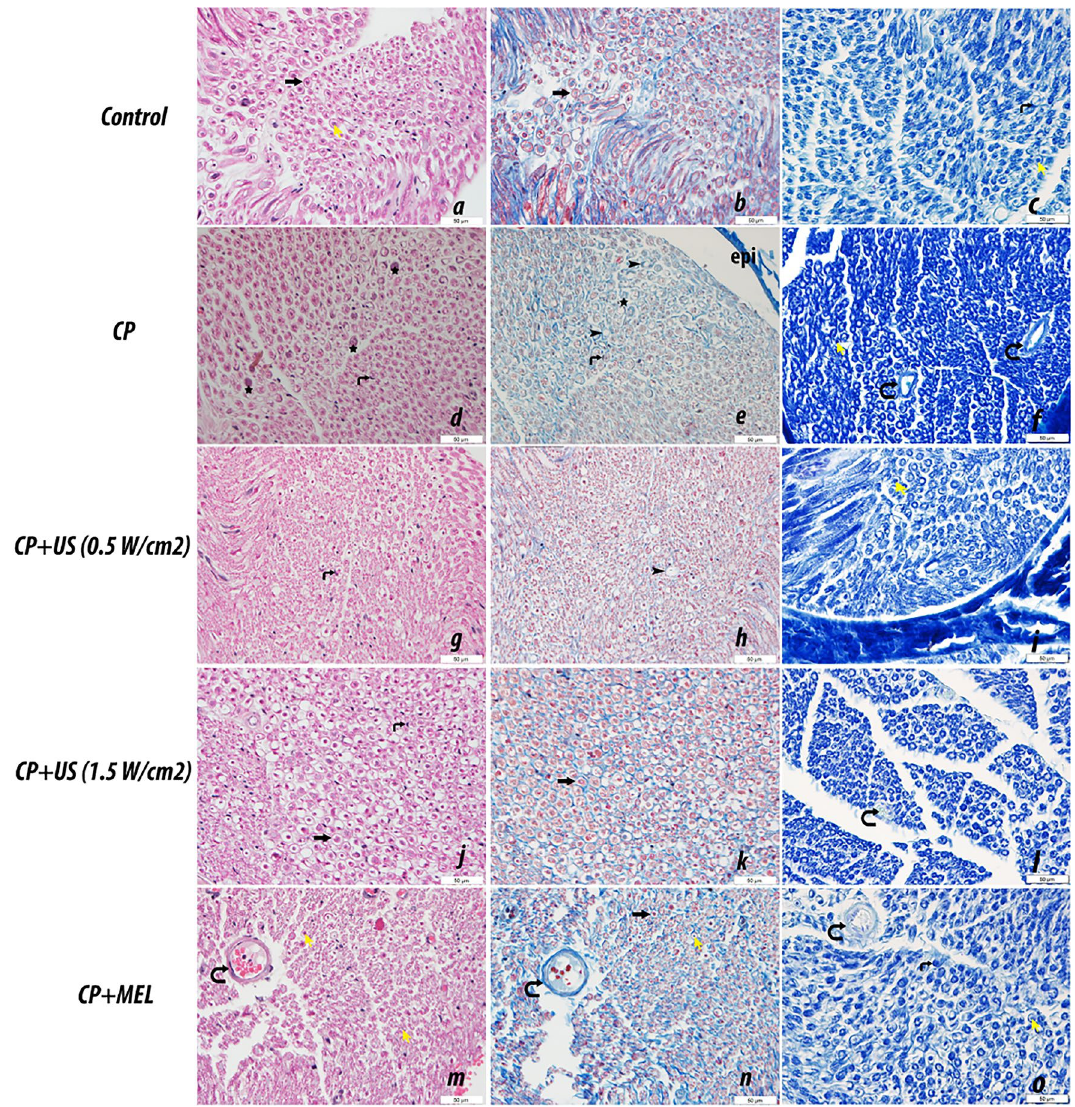
results from each group are presented. Notable features are indicated on the figure as follows: myelinated nerve fiber ( ), epineurium (epi), axon degeneration ( ), axon ( ), Schwann cell nucleus ( ), nerve fiber degeneration ( ), blood vessel ( ). C, control group; CP, cisplatin administered group; CP + US 0.5 W/cm 2 , cisplatin administered and 0.5 W/cm 2 US treated group; CP + US 1.5 W/cm 2 , cisplatin administered and 1.5 W/ magnification bar = 50